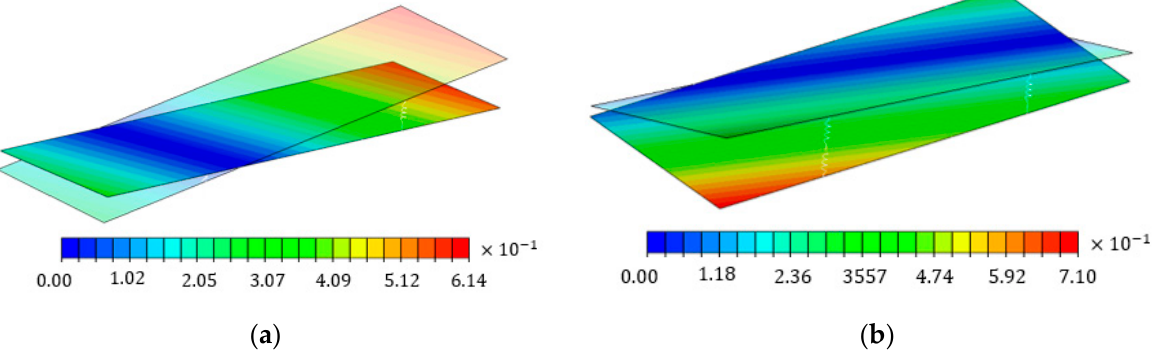
Figure 10. Amplitude displacement distribution (in mm): ( a ) 2nd and ( b ) 3rd natural frequencies. If the displacement imposition is 10 mm on Node 1.